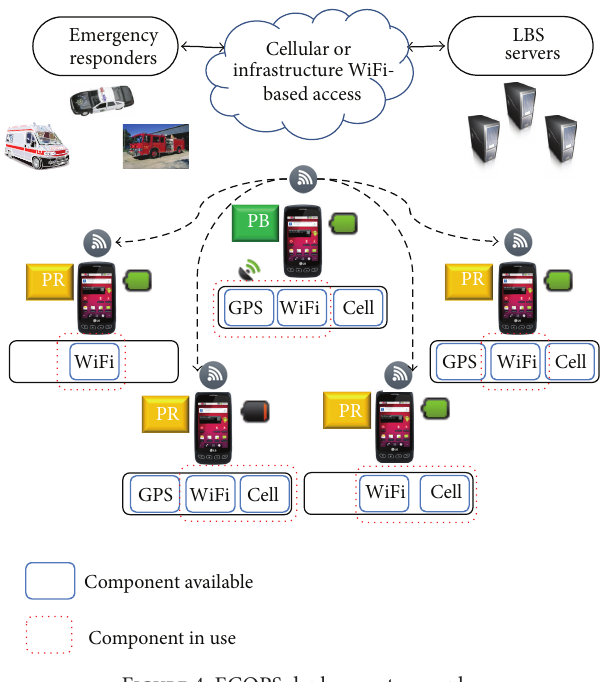
Figure 4: ECOPS deployment example.